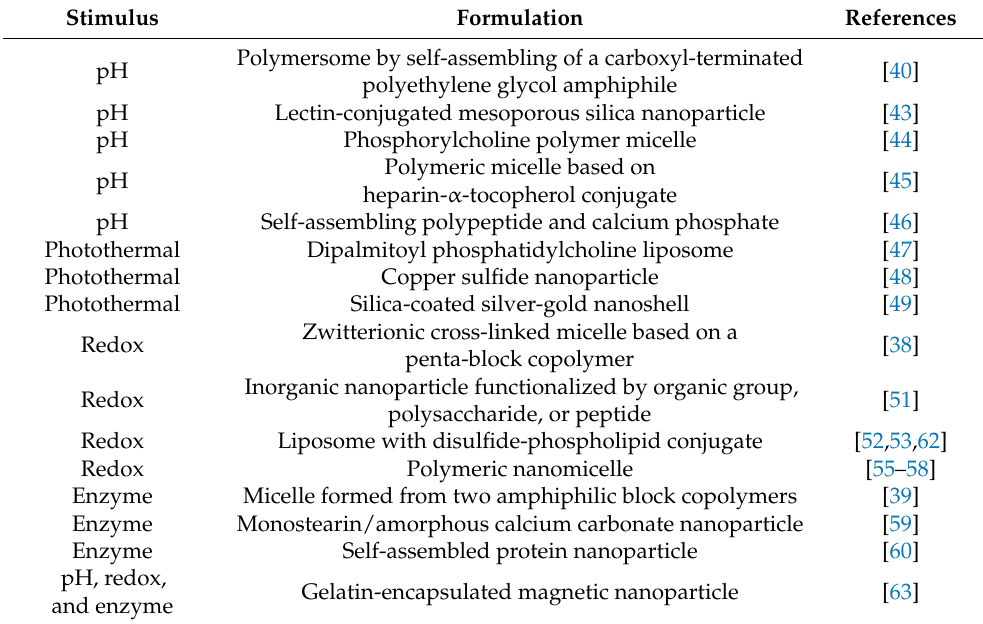
Table 2. Recent publications on stimuli-responsive drug delivery nanocarriers for smart anticancer therapy. Stimulus